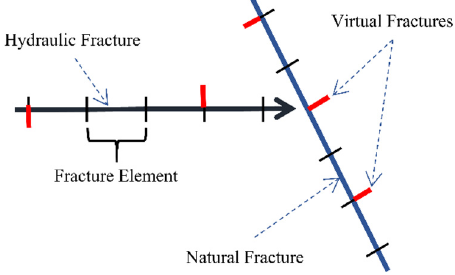
Figure 2. The small fractures around main fractures.